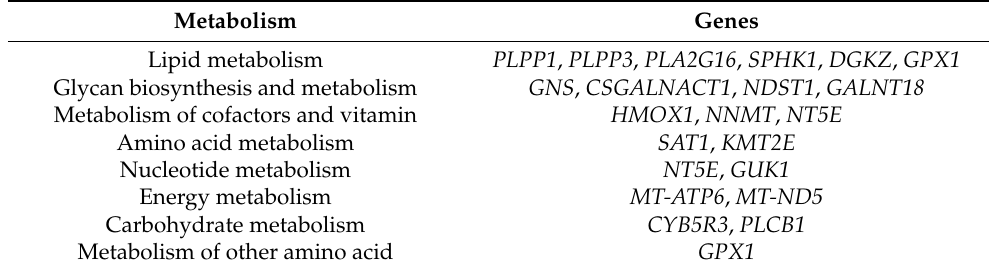
Figure 5. GO and KEGG enrichment analysis of the DEGs only expressed in the upper endothelial cells: ( A ) GO function enrichment of the DEGs only in the upper endothelial cells gradient; and ( B ) circular diagram; ( C ) KEGG pathway enrichment was showed in gradient; and ( D ) circular diagram; ( E ) KEGG pathways annotation in metabolism; ( F ) common DEGs involved in the top five pathways. Table 1. DEGs involved in regulation of substance metabolism in the upper endothelial